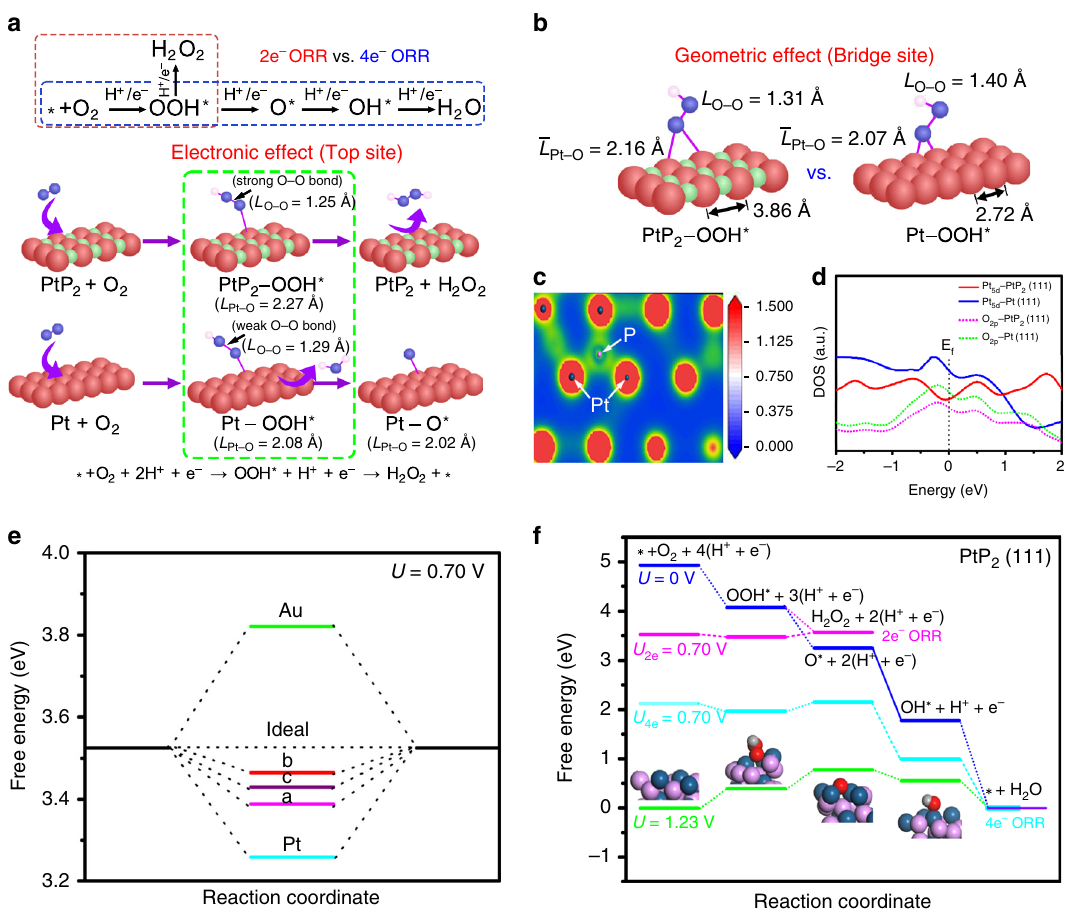
Fig. 3 DFT analysis of reaction intermediates. a Key oxygen intermediates for PtP 2 and Pt during two-electron and four-electron ORR pathways. OOH* adsorbed on top site of PtP 2 and Pt is compared. b Difference between adsorption behavior of OOH* on bridge site of PtP 2 and Pt. c Bader charge distribution of PtP 2 . d Partial density of states (PDOS) for PtP 2 (111) and Pt (111) with adsorbed OOH*. e Free-energy diagram for O 2 -to-H 2 O 2 at 0.70 V. f Free-energy diagram for the two-electron and four-electron ORR on PtP 2